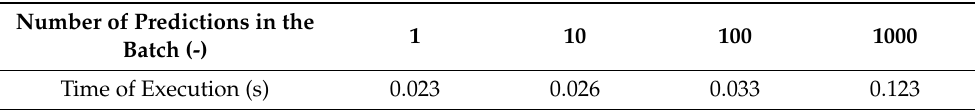
Table 10. Time of execution of various batches for the ensemble of 10 models consisting of 4 layers of 280 nodes per node.